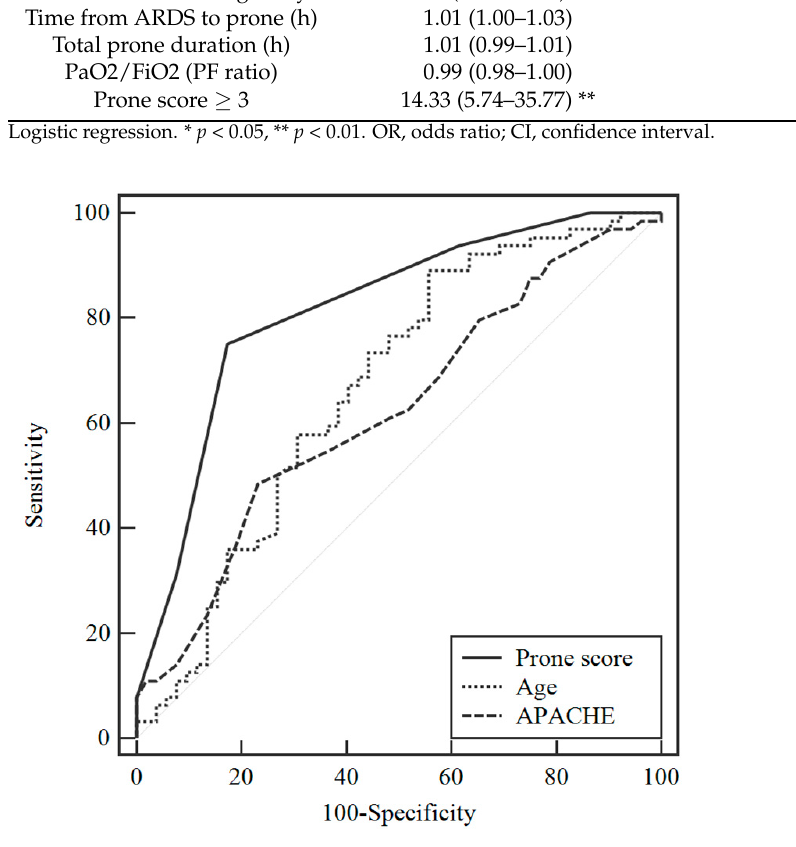
Figure 2. Receiver operating curves analysis of age, APACHE II score, and prone score for predicting ICU mortality in patients with acute respiratory distress syndrome receiving early and prolonged prone positioning. Table 4. Cox analysis of clinical variables associated with ICU mortality in patients with ARDS receiving early and pro- longed prone positioning.